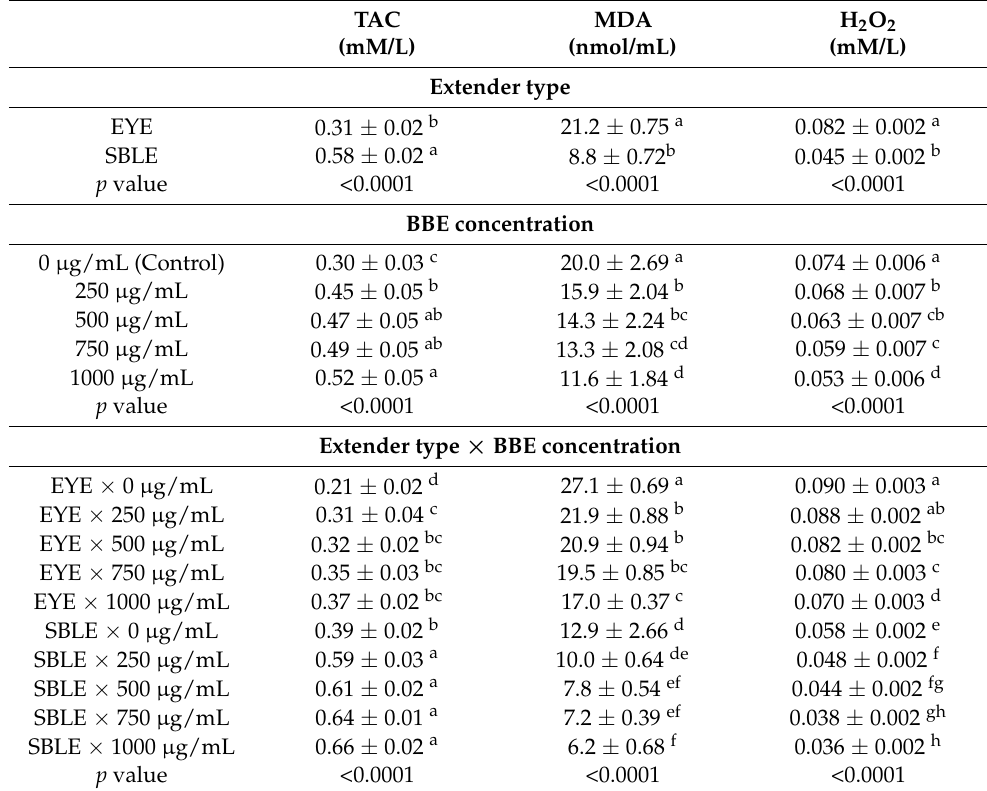
Table 5. The effects of extender type, bee bread extract (BBE) concentration, and their interaction on antioxidant and oxidative markers in the extender of thawed ram